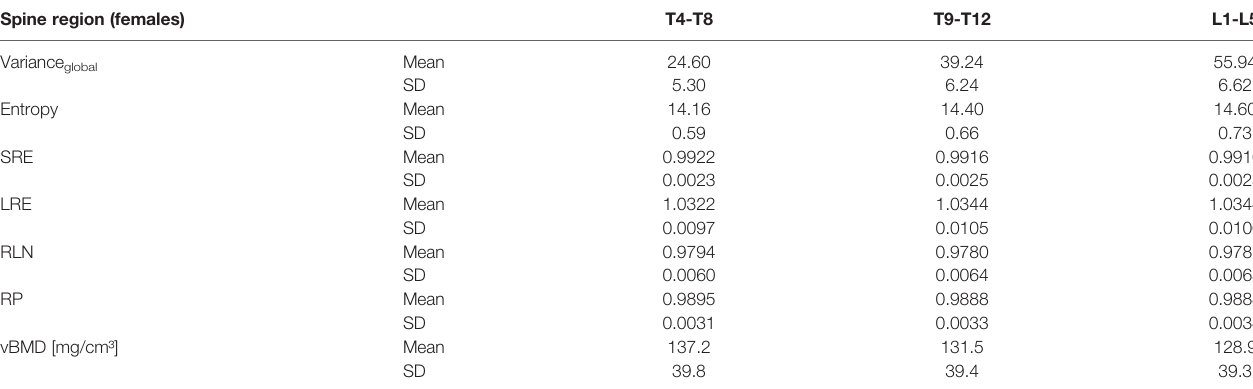
TABLE 4 | Mean and standard deviation (SD) of the six analyzed texture features and vBMD of females, grouped by spine region. Spine region (females)